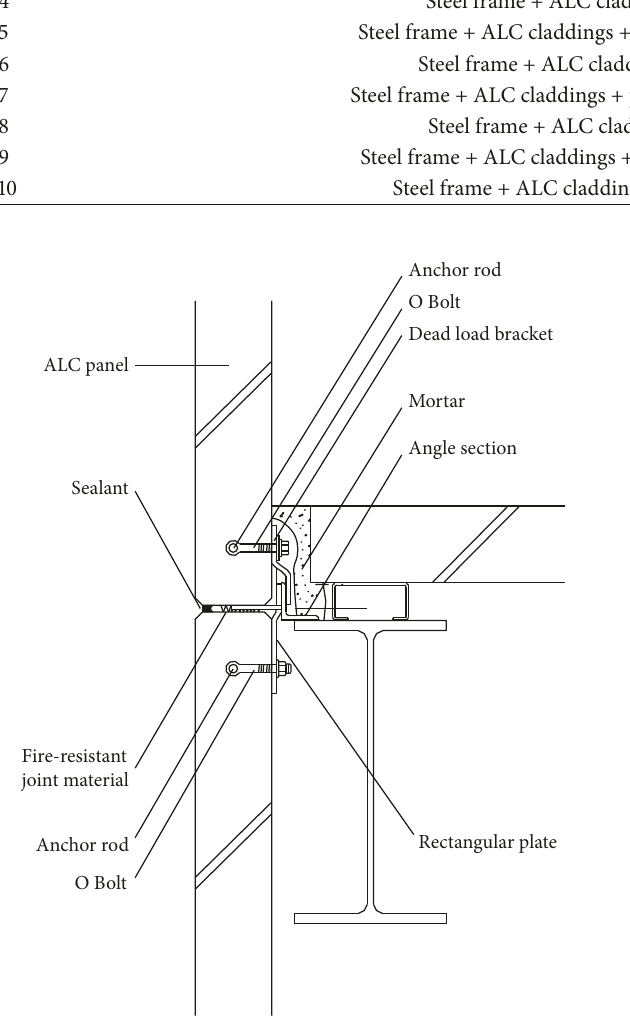
Figure 2: A typical “Rocking Installation